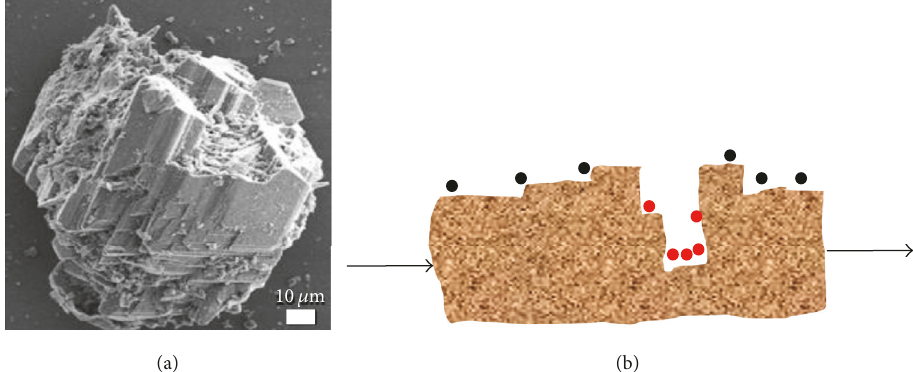
Figure 1: Irreversible and reversible retention sites for NPs illustrated using (a) a SEM picture of a sand grain from crushed Boise sandstone sieved between the size range of 90–105 𝜇 m (adapted from [46]) and (b) a schematic of rough sand grain surface with NPs. Red circles represent NPs trapped permanently, whereas black circles represent NPs that have the potential to escape from their site of